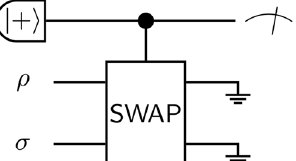
Fig. 4 The SWAP test circuit. The circuit consists of a controlled- SWAP gate with control qubit initialized to þj i . Measuring the control system under the f þj i ; (cid:5)j ig basis yields the outcome þj i with probability ð 1 þ Tr ½ ρσ (cid:4)Þ = 2 . The ground symbol means discard- ing the